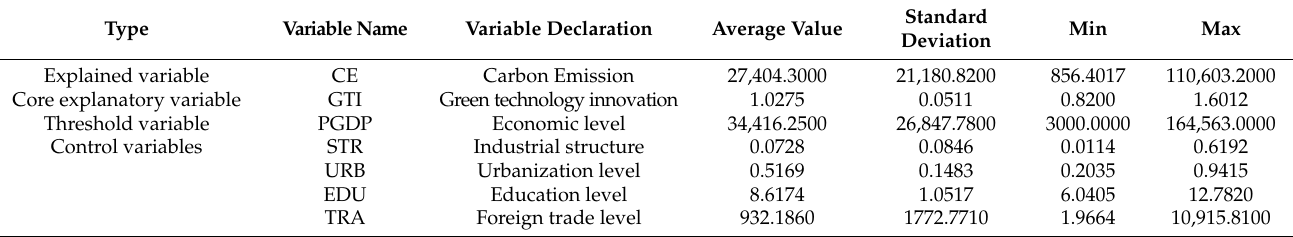
Table 2. Statistical description of